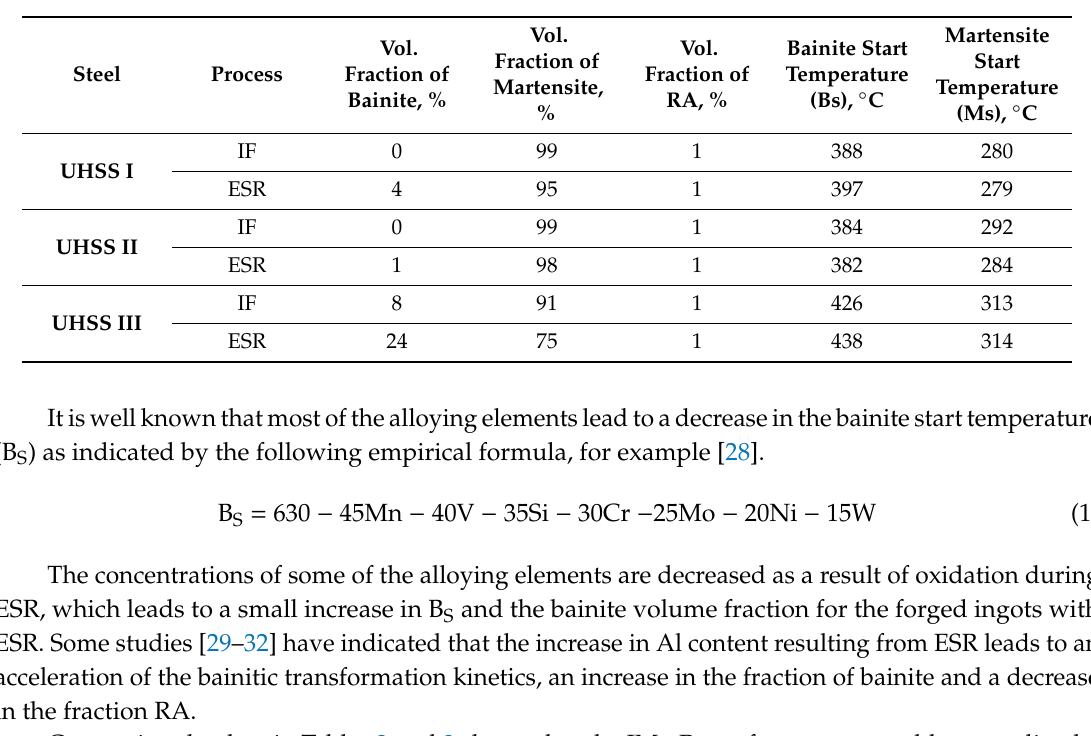
Table 2. Volume and carbon percentage of RA and PAGS in UHSS I, II, and III without and with ESR. Heat No. Process Vol. Fraction of RA, % 1 Mean % C in RA (C γ ) Mean PAGS, µ m 2 IF 5.2 ± 0.3 0.7 25 ± 2.8 UHSS I ESR 6.5 ± 0.1 0.4 13 ± 1.7 IF 8.1 ± 0.2 1.2 27 ± 3.2 UHSS II ESR 6.6 ± 0.1 IF 7.1 ± 0.2